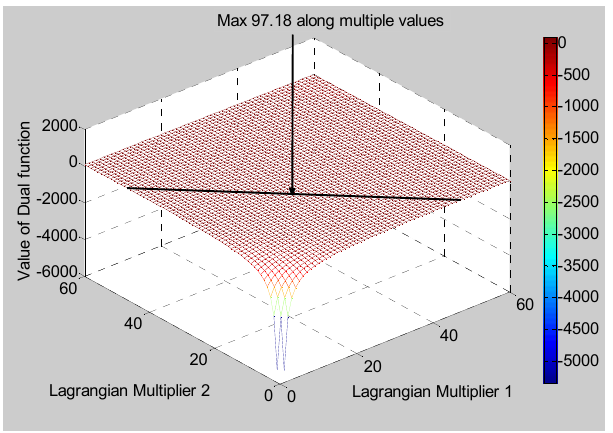
Figure 7. Dual function for a Target Scenario